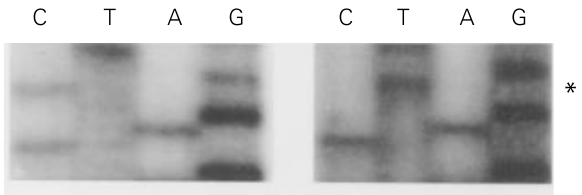
Figure 1 - Direct sequence analysis of the amplified genomic fragment of exon 3 of the V2(R) gene showing a polymorphism* (AGT; right panel) as well as the published sequence (AGC; left panel) of codon